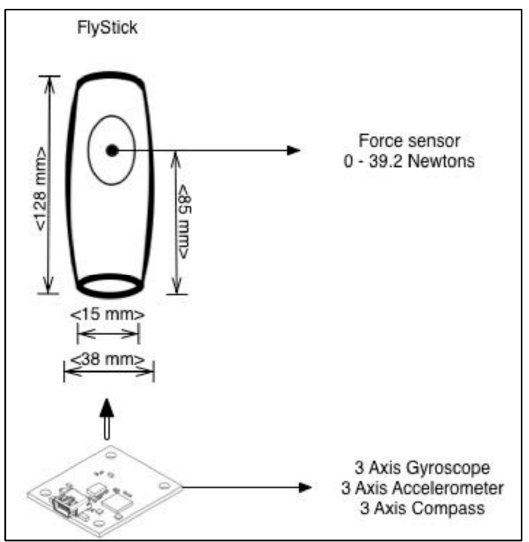
Figure 3. Schematic design of FlyStick.